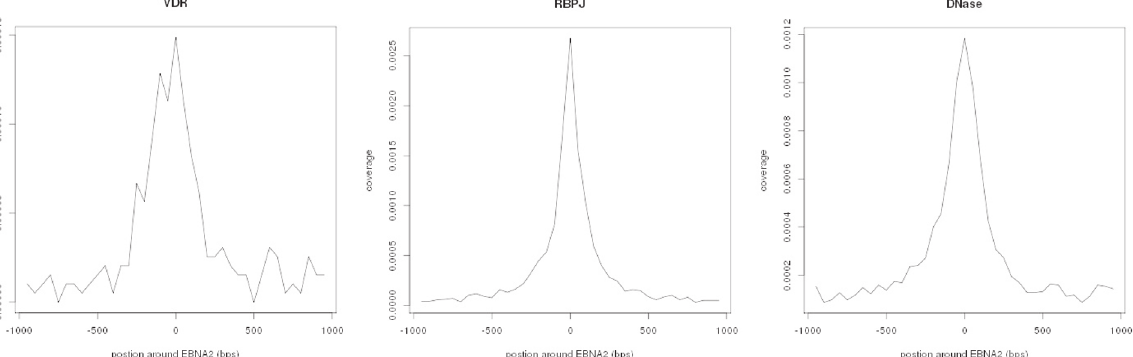
Fig 1. Histogram plots of VDR, RBPJ and DNase peak distribution centered on EBNA2 peak position. In similar analyses, when the position of two factors (e.g., co-factors) across the genome tends to coincide, the correspondent graph shows a clear middle-point peak, as seen for the relation between EBNA2 and RBPJ (plot in the middle). Refer to the text for